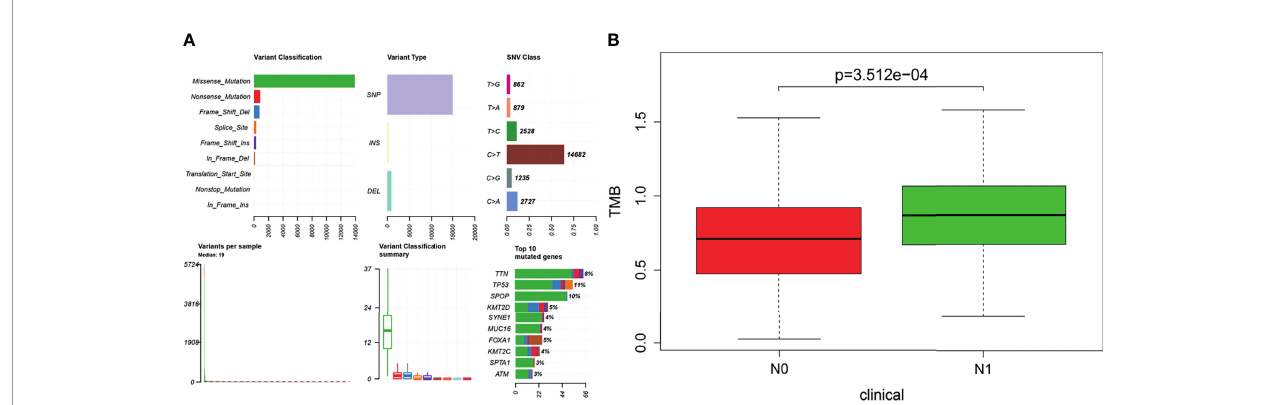
FIGURE 2 | (A) Based on the R software “ maftools ” package (version 3.6.2), the somatic mutation data of prostate cancer were visualized to Variant Classi fi cation, Variant Type, SNV Class, and so on. (B) Tumor mutational burden (TMB) value was positively correlated with lymphatic metastasis in patients with prostate cancer (P < 0.001). The longitudinal coordinate is the relative value of TMB; N0 indicates no lymph node metastasis, and N1 indicates lymph node metastasis.